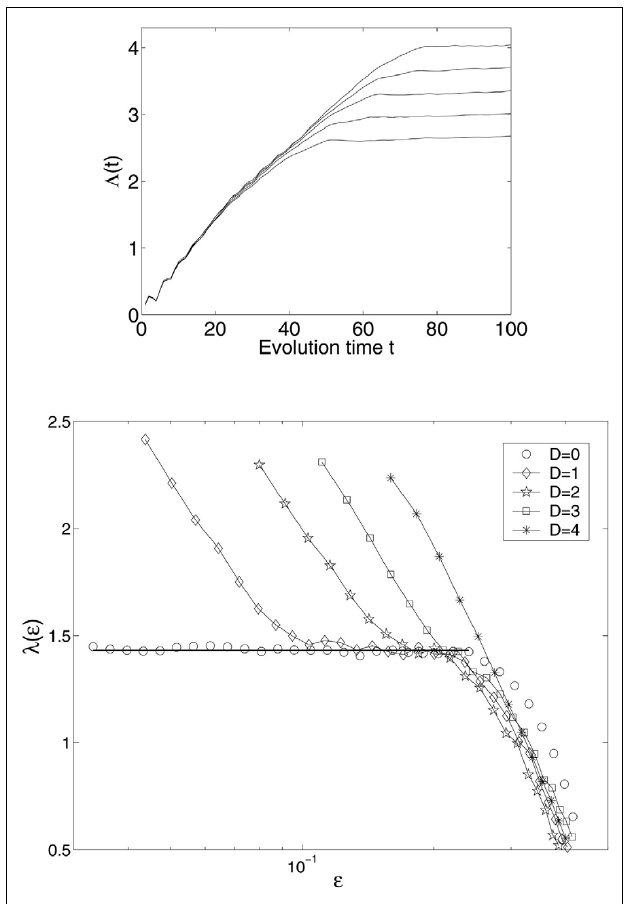
FIGURE 4 |Top: Λ ( t ) curves for the clean Lorenz system; bottom: SDLE λ ( ε ) curves for clean and noisy Lorenz